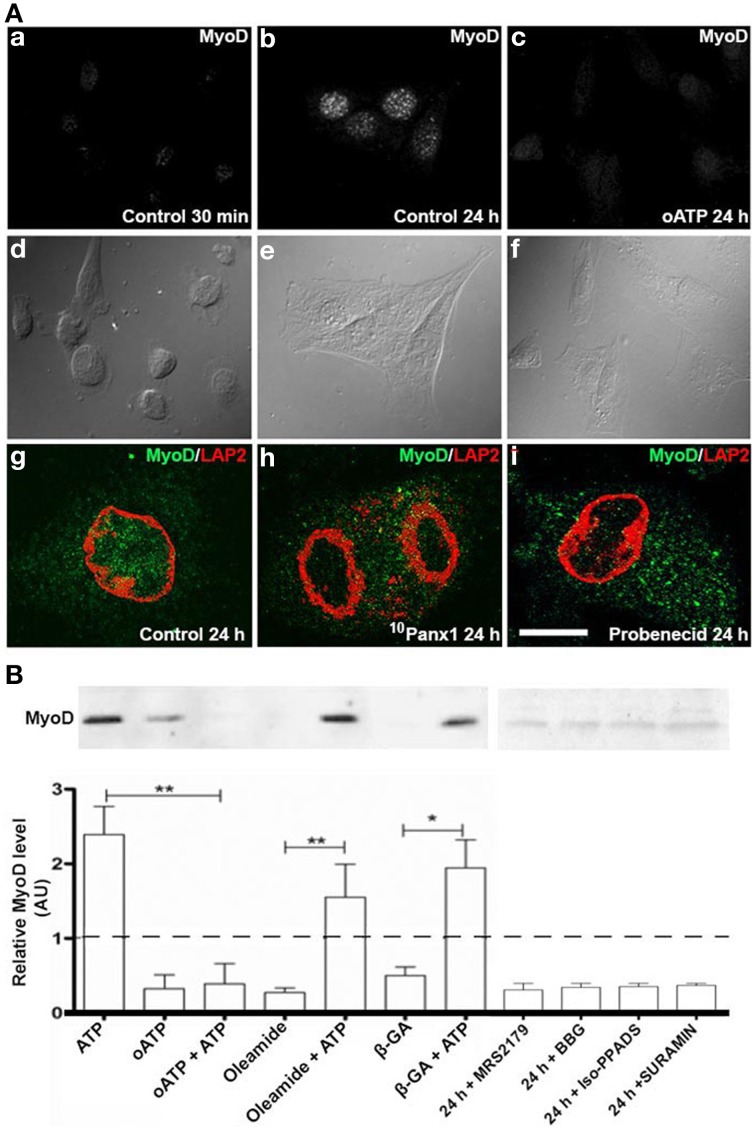
C2C12 RCs require functional P2X receptors and Panx1 channels for myogenic commitment acquisition. (A) Immunofluorescence detection of MyoD in C2C12 RCs cultured for 0.5 h (Aa) and 24 h in (Ab) the absence or (Ac) presence of 150 mM oATP. Ad–Af are contrast phase views of fluorescent fields shown in Aa–Ac, respectively. Bar = 20 nm. Ag–Ai show the presence of MyoD (green) in nuclei, marked by LAP2 (red), a nuclear membrane marker, at 24 h of RC cultures, in normal (Ag), siPanx1 (Ah), and probenecid (Ai, 1 mM) treated cells. (B) Two consolidates of at least three Western blot analyses of C2C12 RCs under control conditions (24 h) or after treatment for 24 h with 300 μM ATP, 150 μM oATP, 30 μM MRS2179, 200 μM brilliant blue G (BBG), 50 μM iso-PPADS, 200 μM suramin or HC blockers added simultaneously: 50 μM b-GA, 100 μM oleamide in the absence or presence of 300 μM ATP. All values were normalized to the control value of each experiment. *p < 0.05 and **p < 0.01.